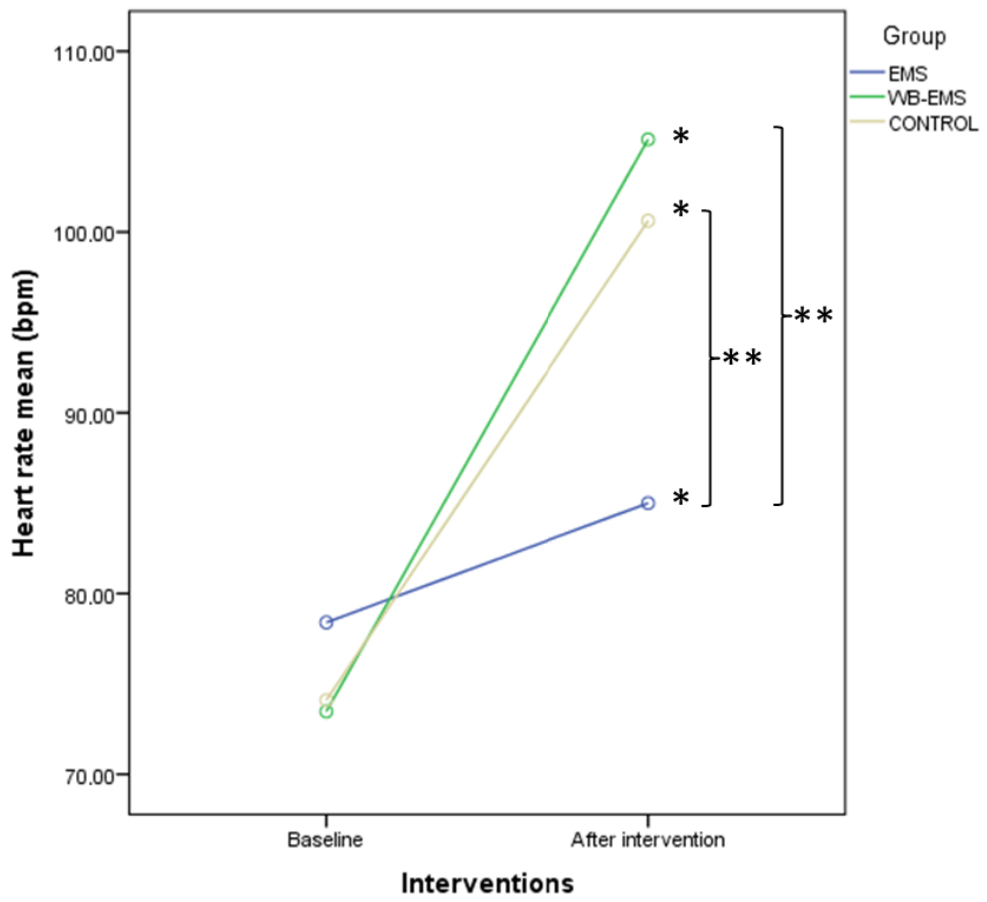
Figure 8. Linear graphs showing HR means before and after interventions as well as intra- and intergroup comparisons among the EMS, WB-EMS, and control groups. Abbreviations: bpm, beats per minute; EMS, electrical muscle stimulation; WB-EMS, whole body electrical muscle stimulation. * Intragroup comparisons showed statistically significant differences ( p < 0.05). ** Intergroup comparisons showed statistically significant differences ( p < 0.05).